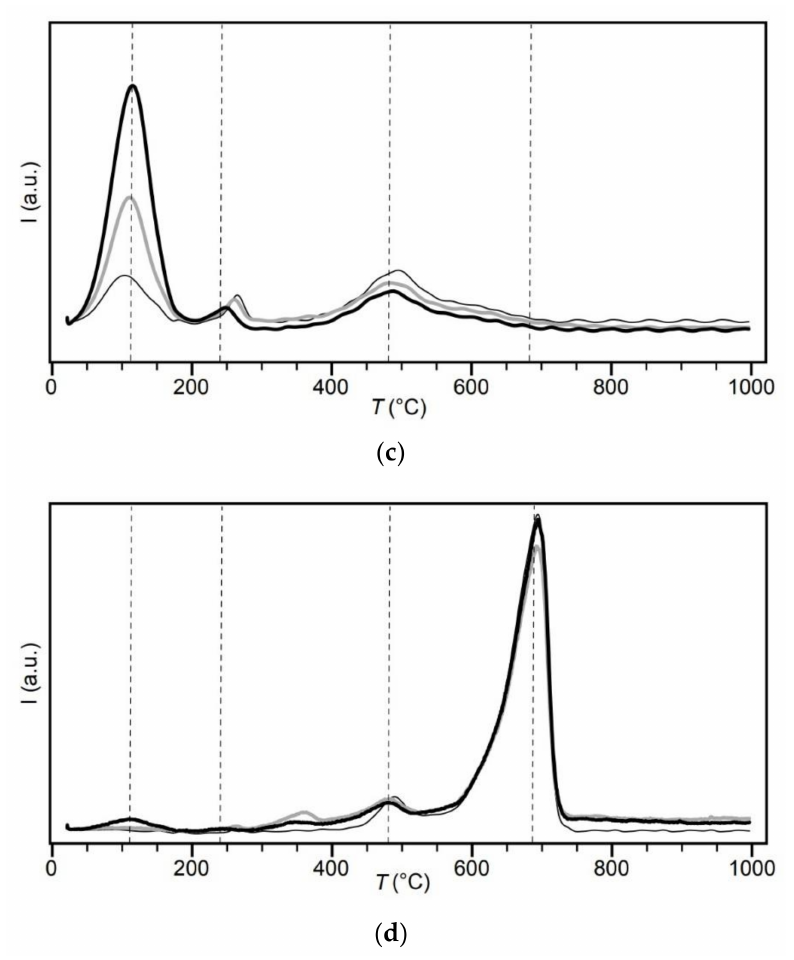
Figure 3. TA-EGA. Differential thermal analysis ( a ), derivative thermogravimetry curves ( b ), EGA curves for water ( c ), and CO 2 ( d ) of the powder samples. Table 2. Aqueous leachates data for the studied BCV samples at three different solid-to-liquid